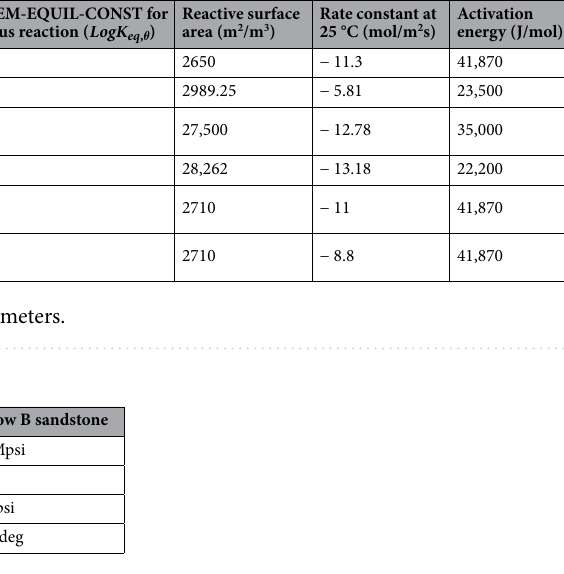
Table 4. Mechanical rock properties of Morrow B sandstone and upper Morrow shale.